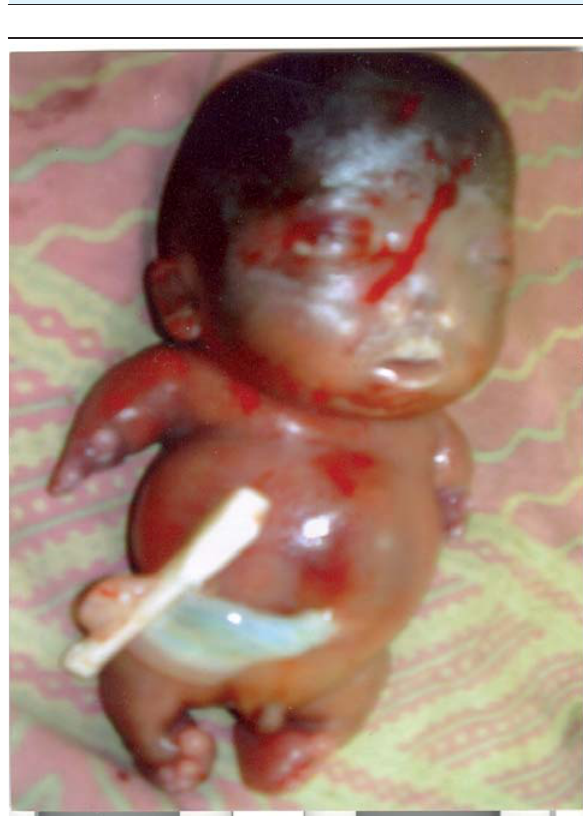
Figure 2. Postnatal photograph of fetus